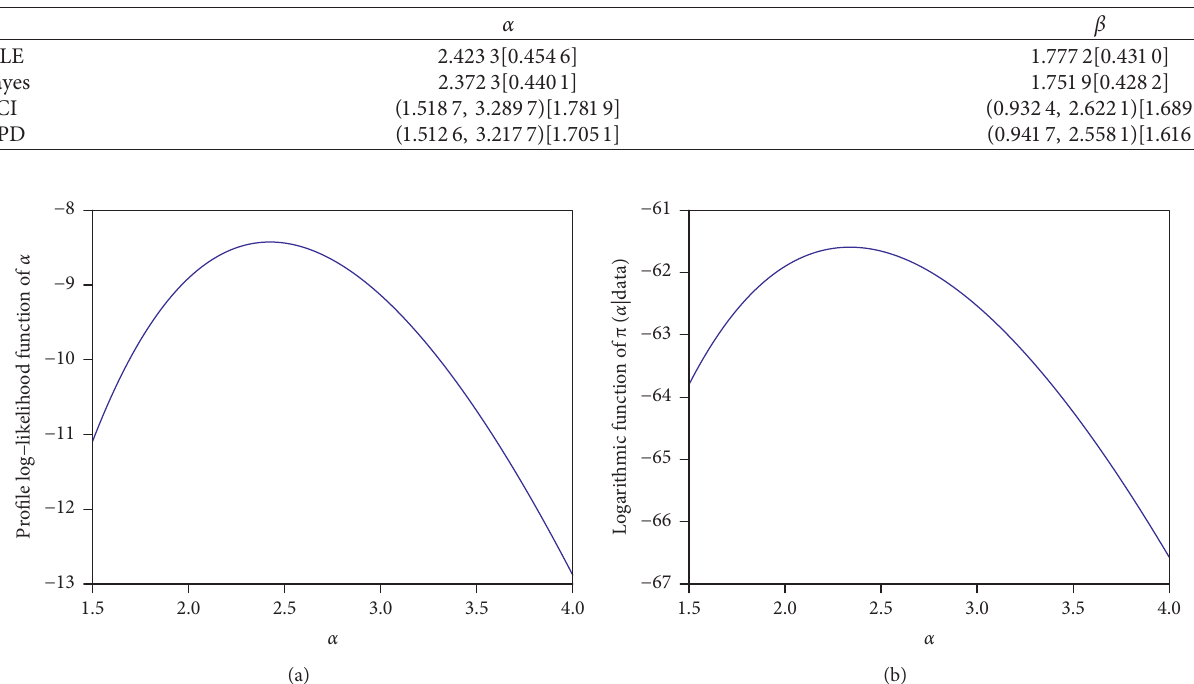
Figure 4: The profile log-likelihood (a) and the posterior marginal density function (b) of α under ball-bearings failure data.